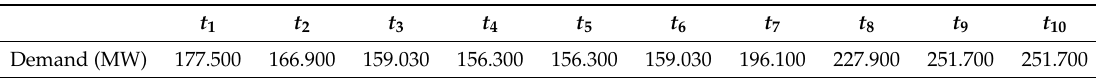
Table 4. Demand of the system.